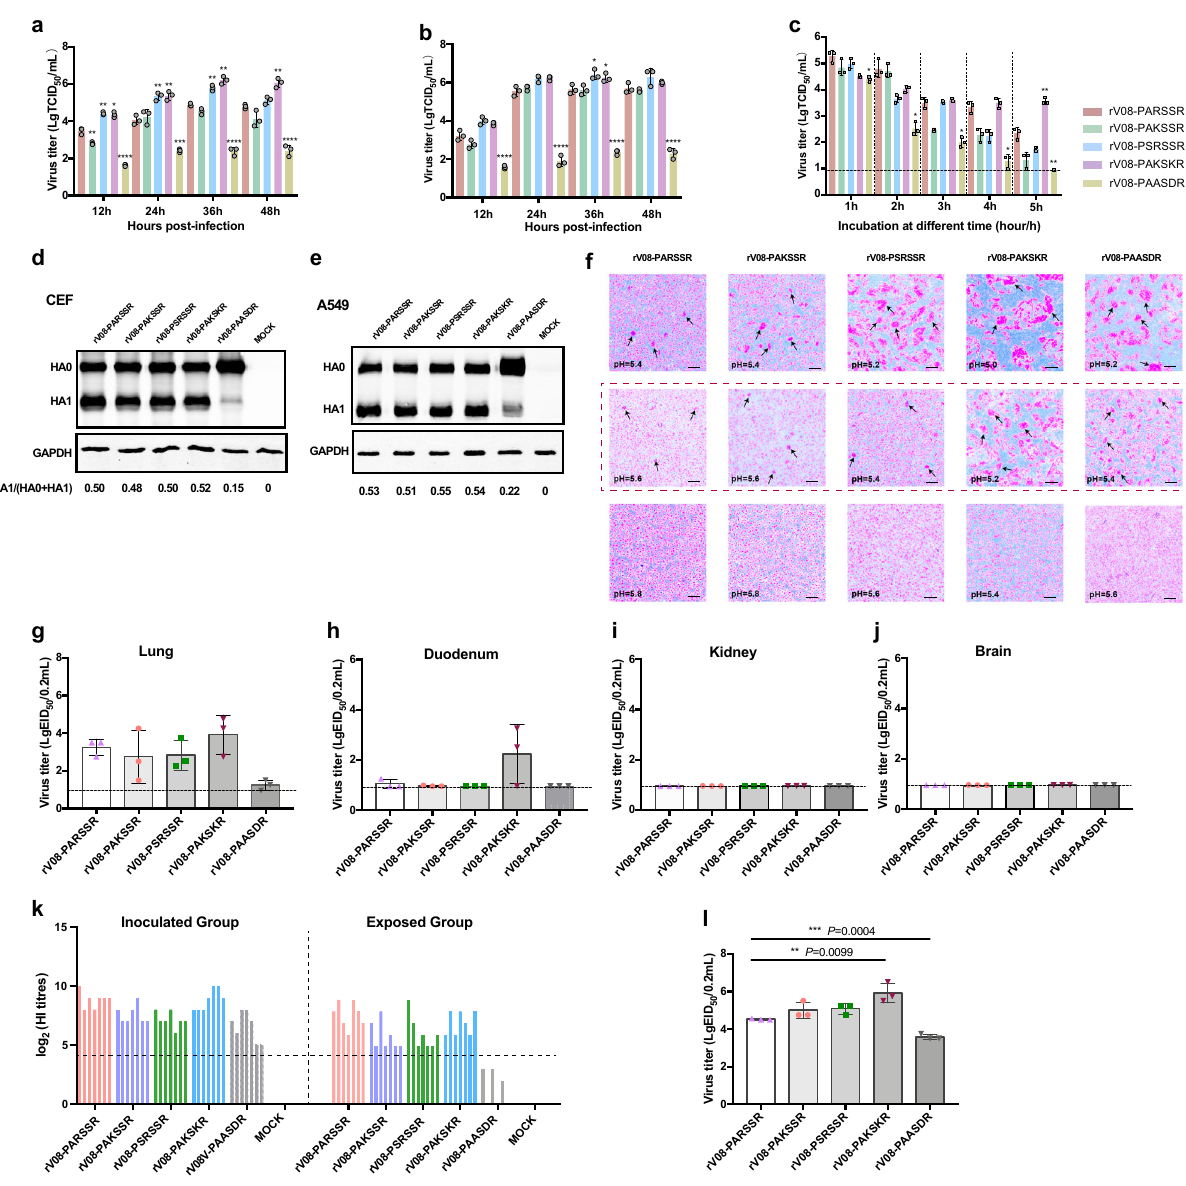
Fig. 3 The biological characteristics of in fl uenza A(H9N2) in vivo and in vitro. Growth curves after inoculation of each virus at a multiplicity of infection (MOI) of 0.001 into ( a ) MDCK cells and at an MOI of 0.001 into ( b ) CEF cells. Each point on the curve is the mean ± standard deviation from three independent experiments. The independent-samples t test was used for analysis. c Thermo stability of the in fl uenza A(H9N2) viruses. The in fl uenza A (H9N2) viruses were incubated for 1, 2, 3, 4, and 5 h at 50 °C. The titers of heat-treated recombination viruses were determined by TCID 50 assay in MDCK cells. Western blots of CEF ( d ) and A549 ( e ) cell cultures inoculated with fi ve in fl uenza A(H9N2) virus at an MOI of 0.01 in the presence of 1 μ g/ml trypsin for 24 h. f Syncytia formation induced by fi ve in fl uenza A(H9N2) viruses in Vero cells. Cultures of Vero cells were inoculated with H9N2 viruses at MOI of 1 for 16 h, followed by incubation with 10 μ g/ml of TPCK-trypsin for 15 min to cleave expressed HA0. To induce syncytia formation, Vero cells were incubated for 5 min with fusion buffers of pH values ranging from 5.0 to 5.8, with 0.2 unit increments, and were visualized 3 h later. Representative images at pH values of 5.0 to 5.8 derived from three replicates are shown. Five groups of ten 5-week-old SPF chickens were infected intranasally with 10 6 EID 50 / 200 μ L of each virus. g Viral titers in the lungs of three inoculated chickens. h Viral titers in the duodenum of three inoculated chickens. i Viral titers in the kidney of three inoculated chickens. j Viral titers in the brain of three inoculated chickens. k Antibody titers of inoculated and exposed chickens at 14 dpi. An HI titer ≥ 1:16 was considered seroconversion. Five groups of three female BALB/c mice were intranasally inoculated with 10 6 EID 50 /50 μ L of the H9N2 viruses. Three mice from each group were euthanized at 4 dpi. Viral titers in the mouse lungs ( l ) were shown. The dashed lines represent the detection limit. The independent-samples t test was used for